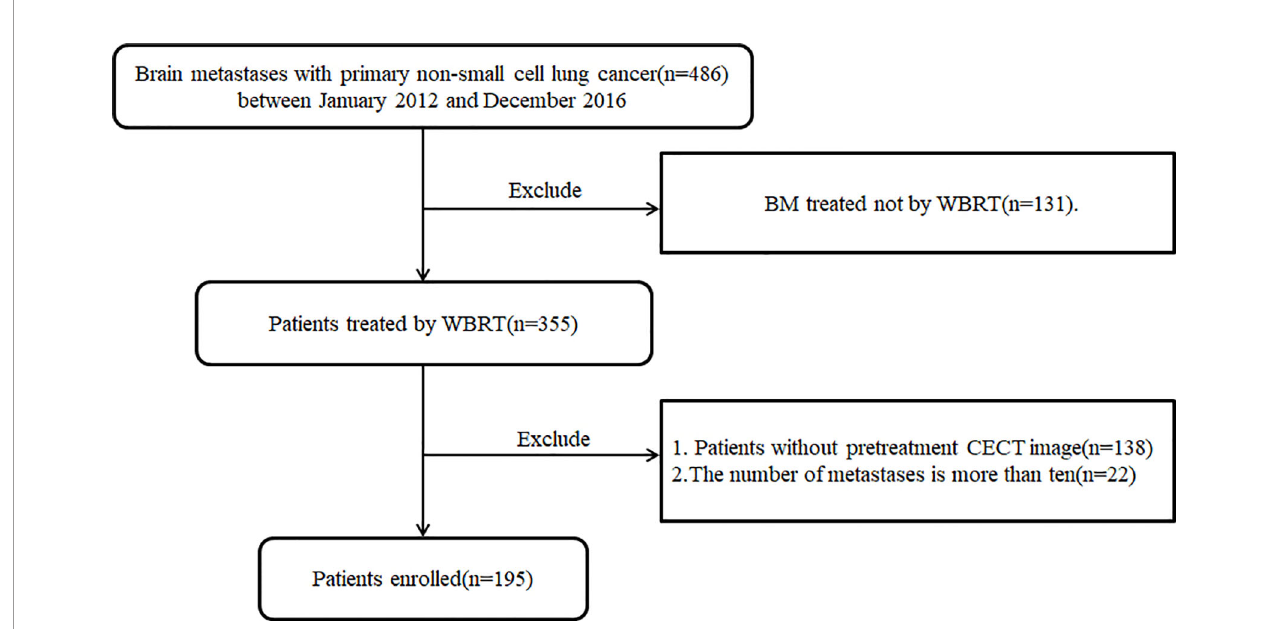
FIGURE 1 | The fl owchart of patients ’ selection for this retrospective study.